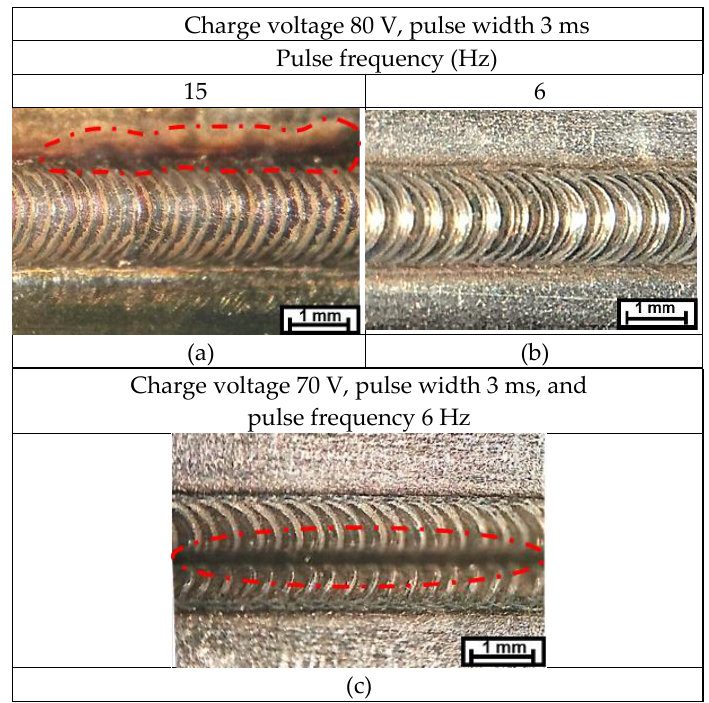
Figure 8. Weld appearance ( a ) Oxidation, ( b ) Good appearance with nice ripples, and ( c ) Lack of fusion.